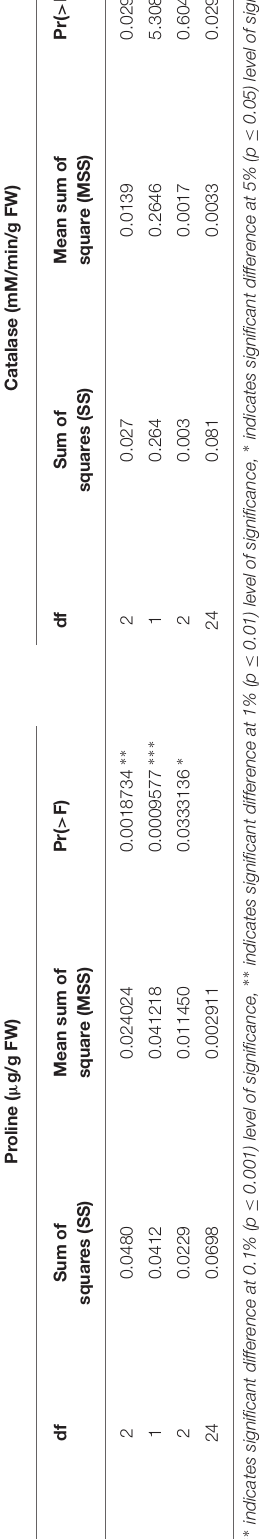
( Table 3 ). The content of chlorophyll a, chlorophyll b, and carotenoid increased in Panicum turgidum plants along with mung bean crops due to the inoculation of AMF